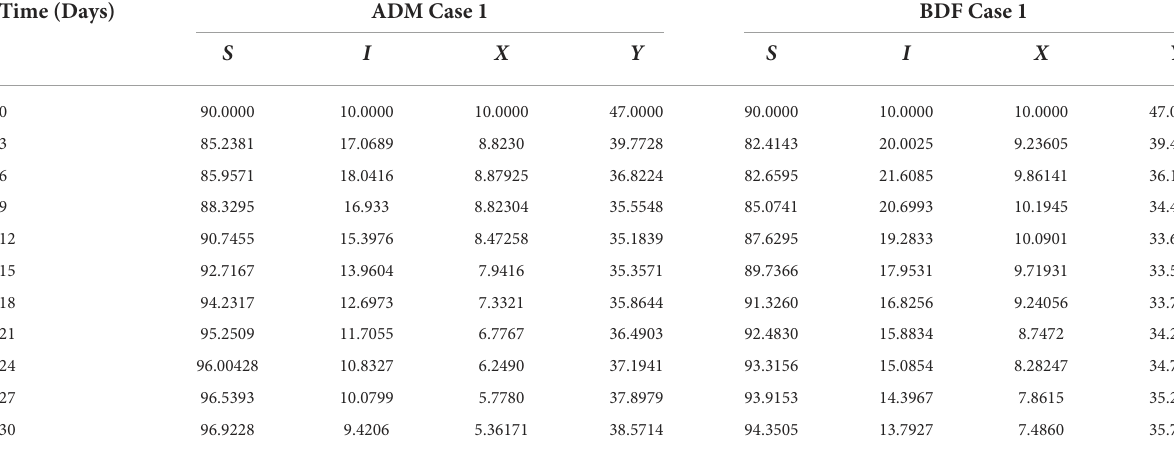
TABLE 5 Numerical outcomes of non-linear PVPMV model A2 for case-1 of scenario 1. Time